Question: What visual encoding does this figure use to show its data?
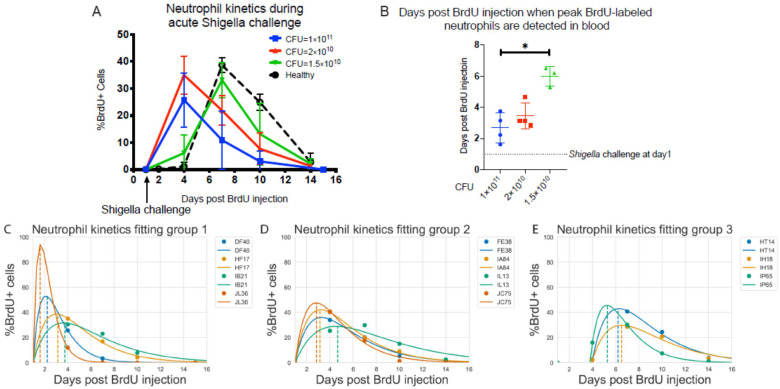
Answer: line